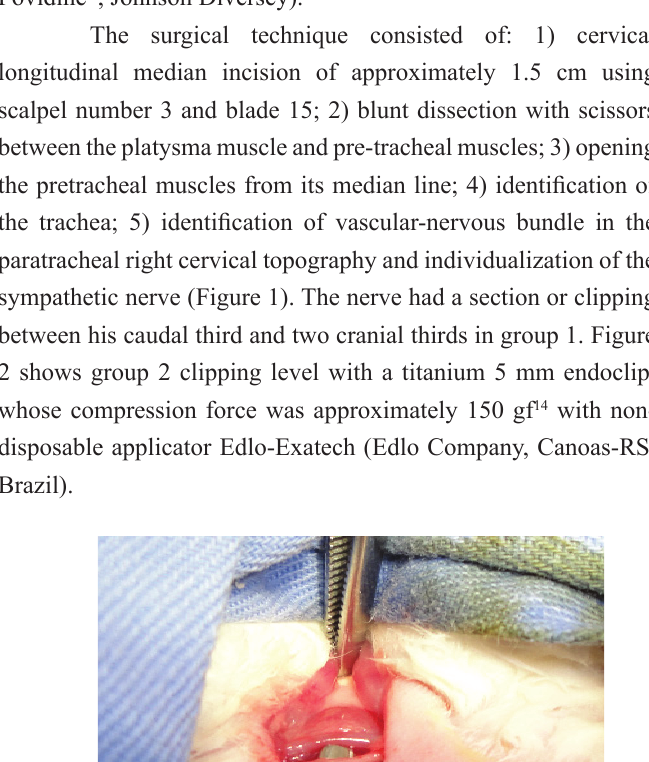
FIGURE 2 - Clipping of cervical sympathetic